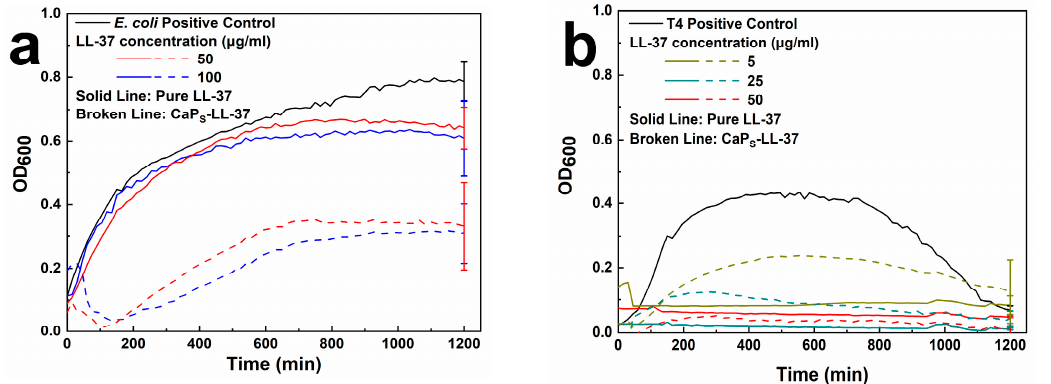
Figure 7. Growth curves (OD 600 vs. time) of ( a ) E. coli (HVM52); ( b ) S. pneumoniae (T4), after subtraction of background (Figure S6). Measurements had been performed at least in triplicate and mean values are presented with representative error